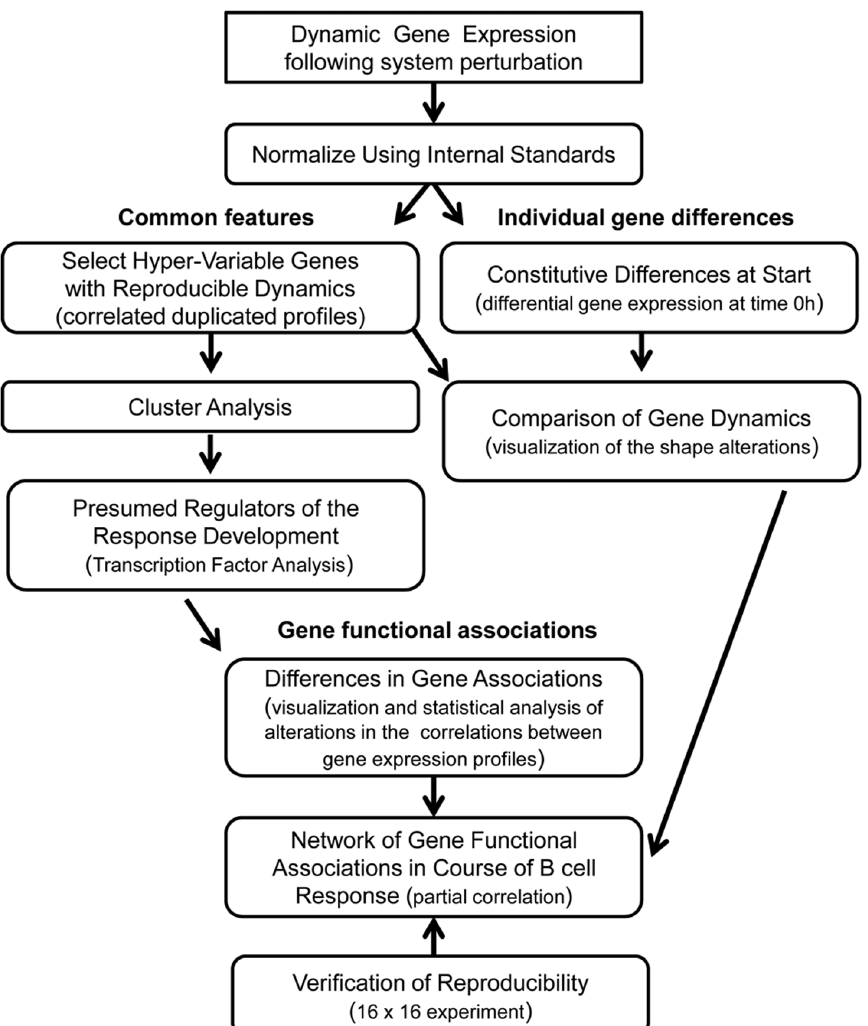
Figure 2. Schematic of pathway dysregulation analysis. The self-verified experimental design of pathway dysregulation analysis is depicted.